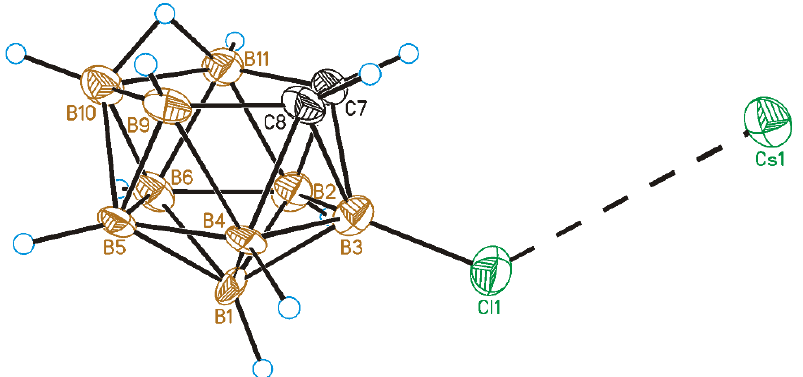
Figure 3. General view of Cs [3-Cl-7,8-C 2 B 9 H 11 ] along with atomic numbering. Thermal ellipsoids are shown at 50% probability level.